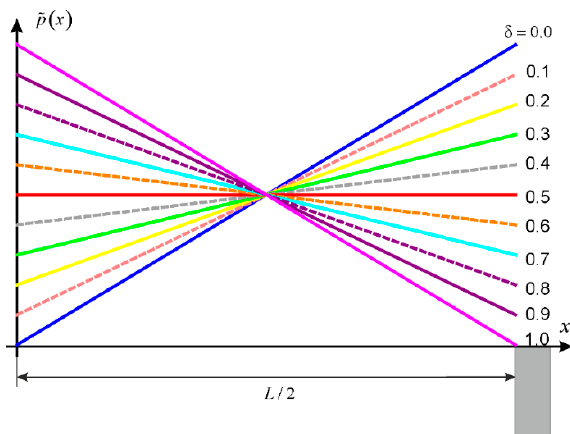
δ . Figure 3. Examples of load distributions depending on parameter δ .